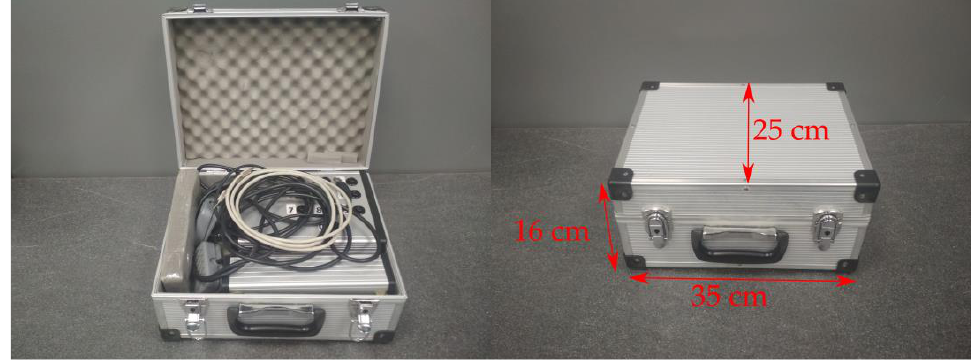
Figure 3. The testing device in transport conditions.